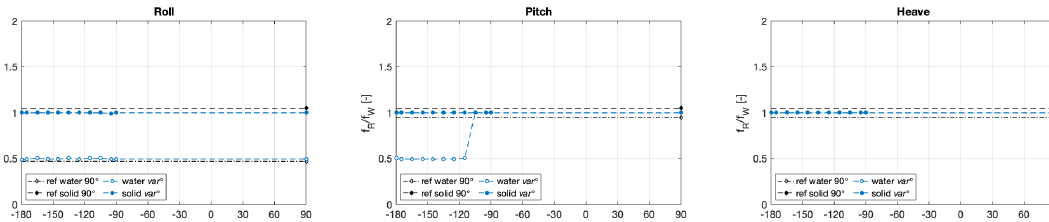
Figure 16. Roll, pitch and heave response for different wave directions with a fixed wave frequency of 0.95 Hz—water (cid:109) and solid (cid:108) ballast option.